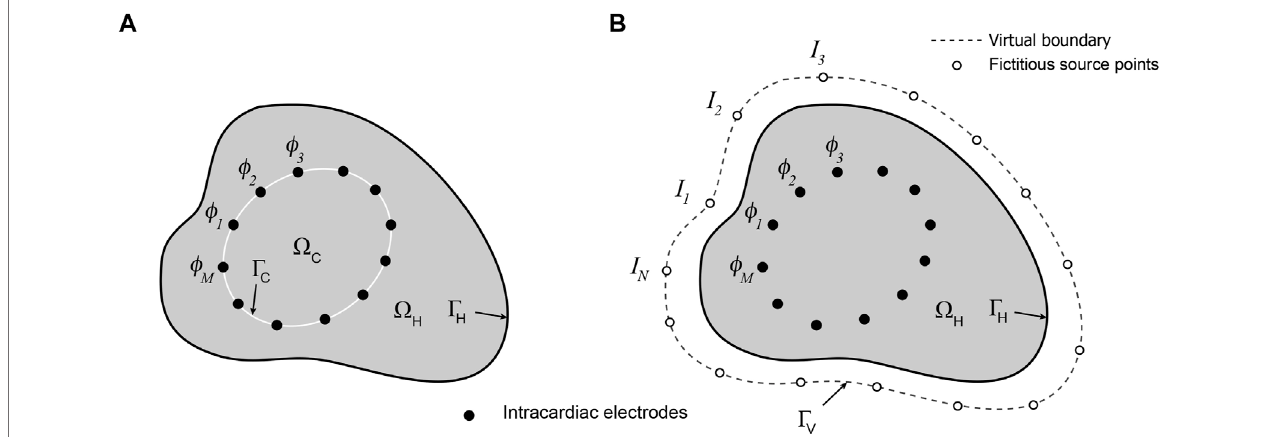
FIGURE 1 | Schematic representations of (A) mesh-based and (B) meshless/MFS formulations of the intracardiac inverse potential problem which seeks to map the potential distribution on the surface Γ H that bounds a heart cavity Ω H from a set of M potentials ϕ C ( x ) sampled at electrodes inside Ω H . In (A) potentials and normal potentialgradientsonthesurface Γ C thatboundstheelectrodesarerelatedtothepotentialdistributionon Γ H andinsolutiondomain Ω H − Ω C .In (B) N fi ctitioussources I i (opencircles)distributedaroundavirtualboundary Γ V outside Γ H generatethecurrent fl uxthatgivesrisetothepotentialdistributionin Ω H .Thesearematchedtothe sampled potentials ϕ C ( x ) enabling potential distribution on Γ H to be estimated.